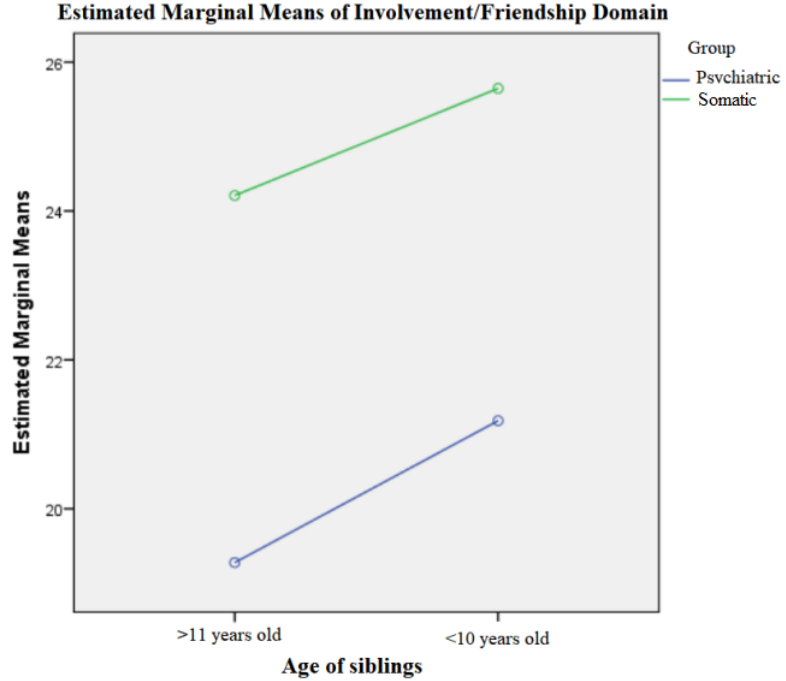
Figure 7. Involvement/friendship field in relation to age and disorder.